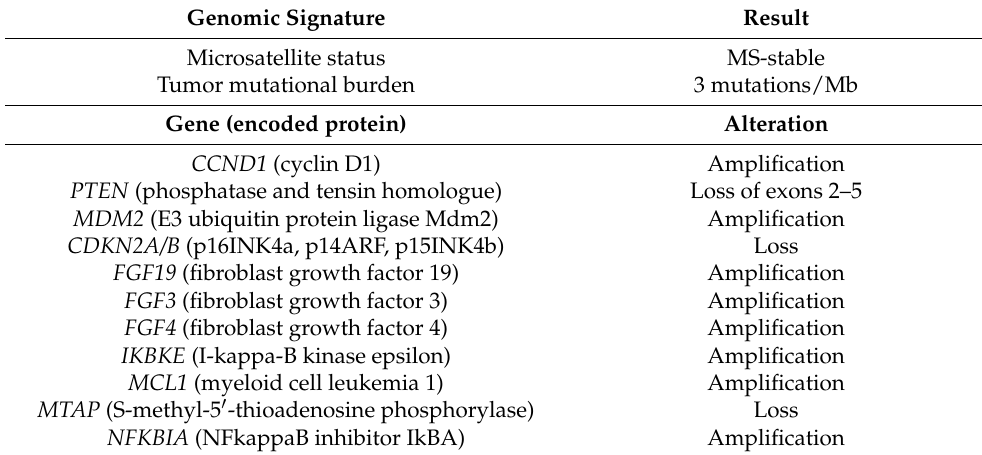
Table 1. The genomic alterations detected in the patient’s tumor